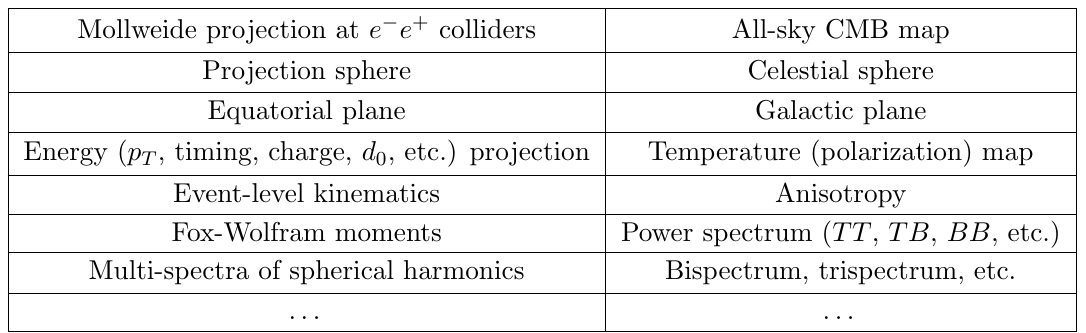
Table 2 . Dictionary between the Mollweide projection at e (cid:0) e + colliders and the all-sky CMB map.